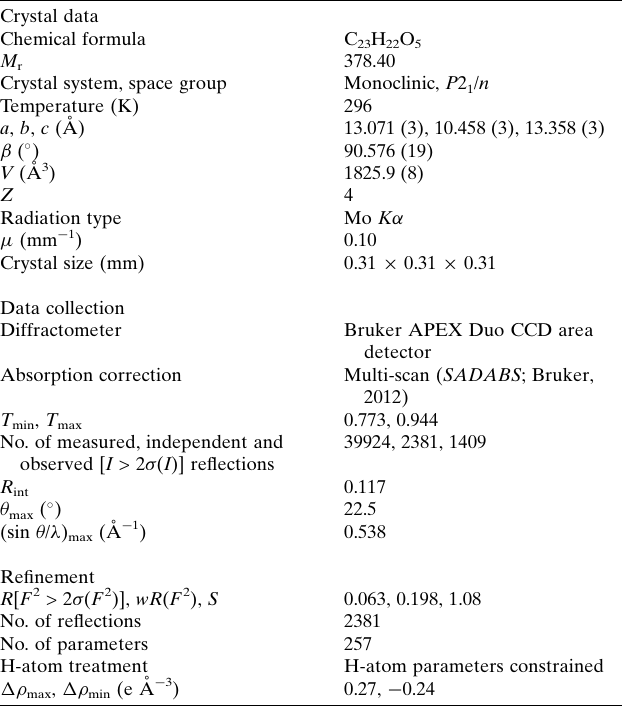
Table 2 Experimental details. Crystal data Chemical